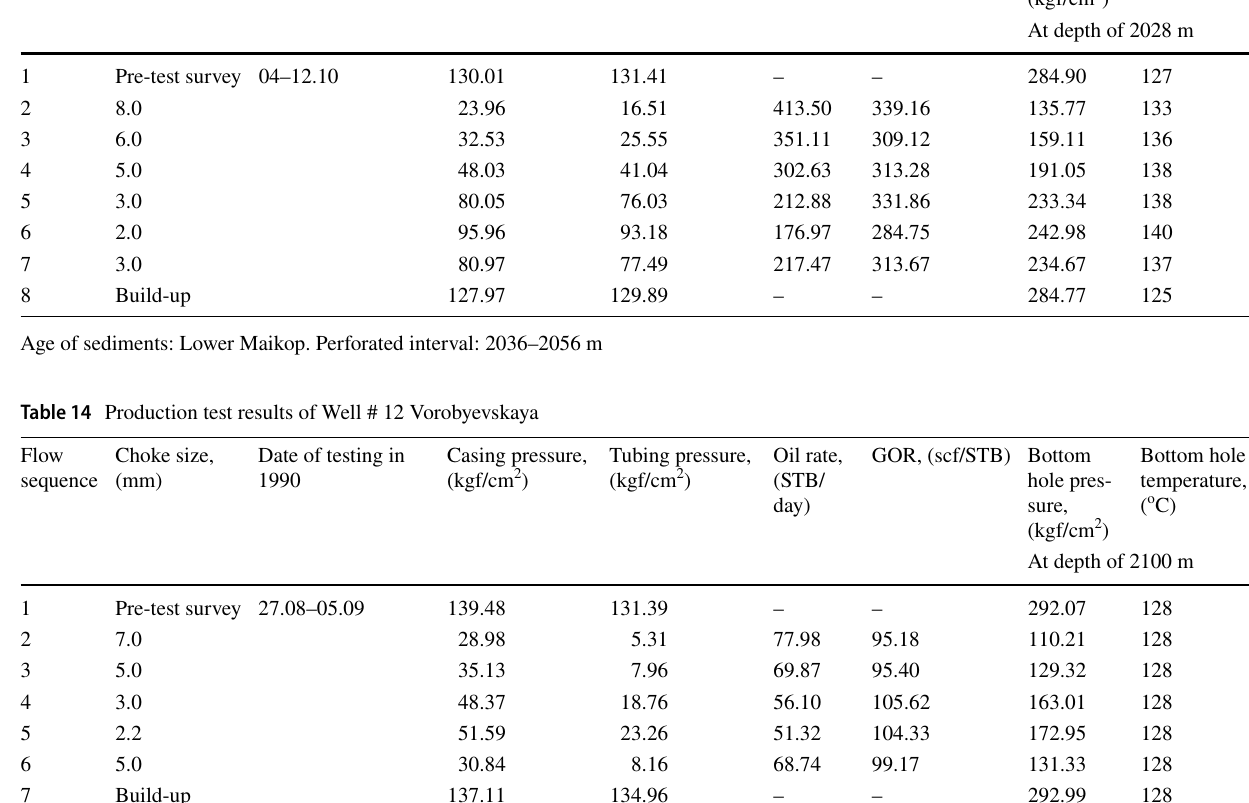
Age of sediments: Khadum formation. Perforated interval: